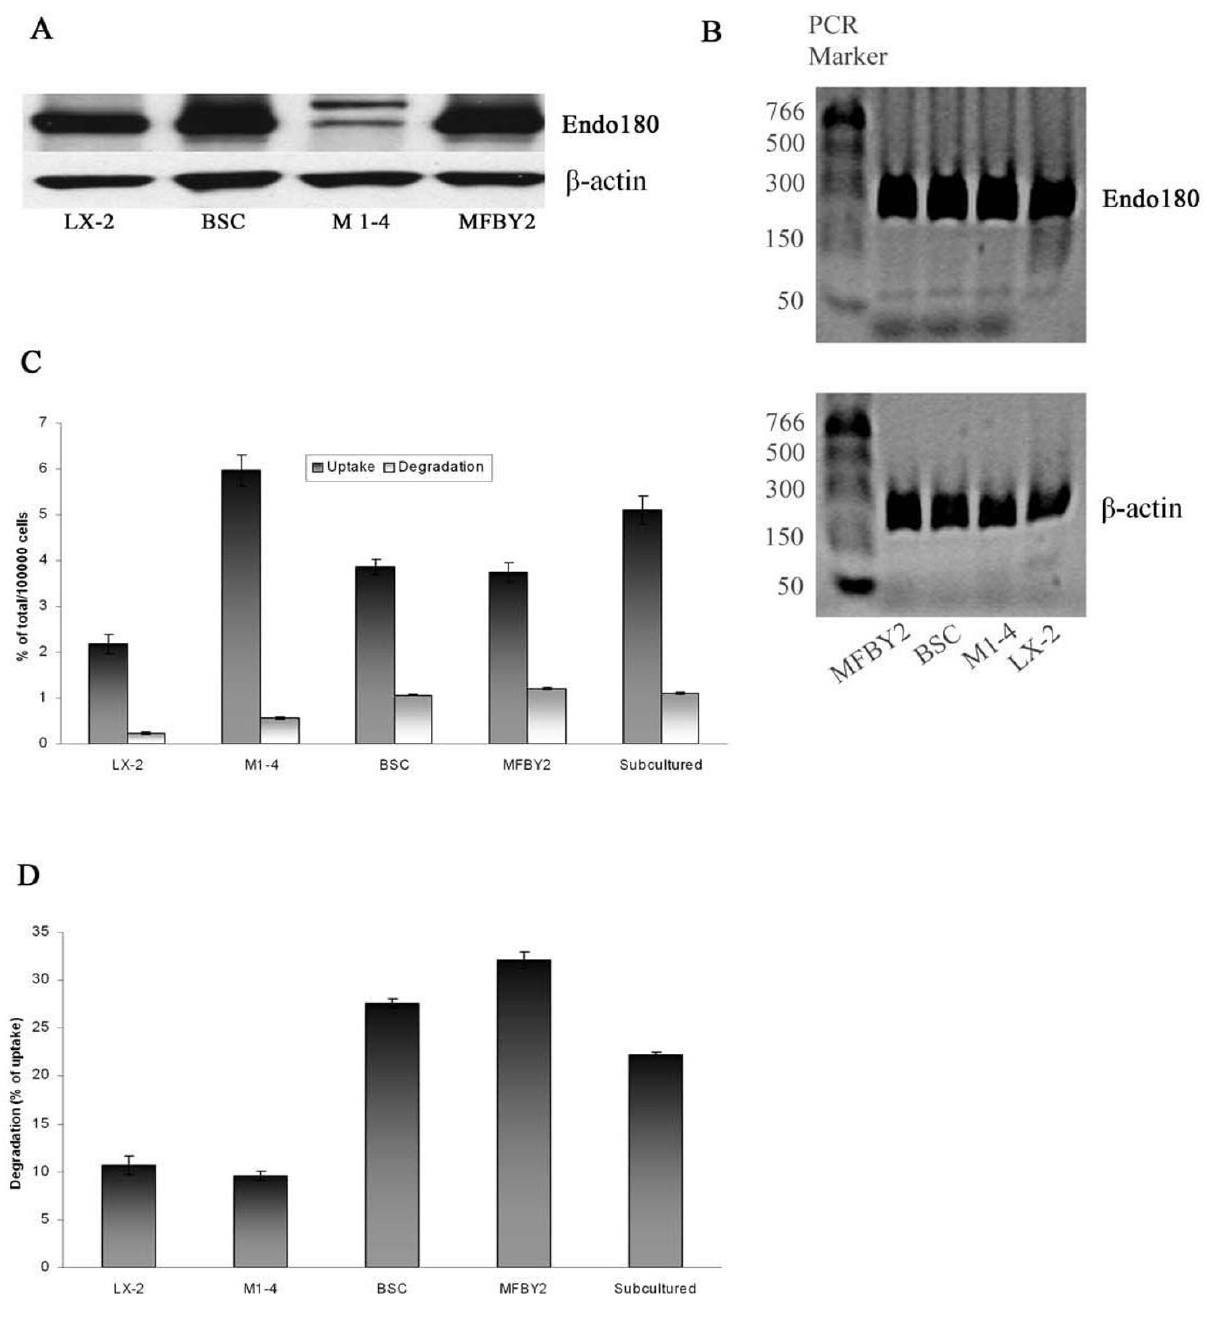
Figure 4 Expression of Endo180 protein and mRNA by four established HSC lines from three different species . Detection of Endo180 and β -actin proteins (A) and mRNAs (B) was performed as described in Figure 2. Results are representative of three (A) or two (B) experiments. (C) Uptake and degradation of denatured collagen by different HSC lines. Cells were grown in 6-well plates, washed, pre-incubation for 45 min at 37°C, and then incubated for 2 h at 37°C with 10 μ g/ml 125 I-TC-collagen. Experimental procedure is as in the legend to Figure 3. (D) The calculated percentage of internalized 125 I-TC-collagen degraded by different HSC lines. Results are shown as means ± SD for triplicate wells and are representative for at least two similar experiments. Cells used from a new passage was treated as a separate experiment. Data are normalized for cell